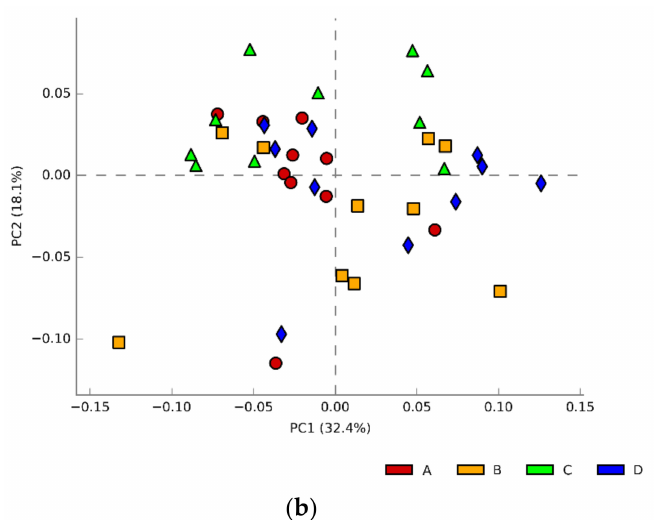
Figure 2. ( a ) Comparison of caecal microbial communities of all experimental groups (family level); ( b ) comparison of caecal microbial communities of all experimental groups (genus level).